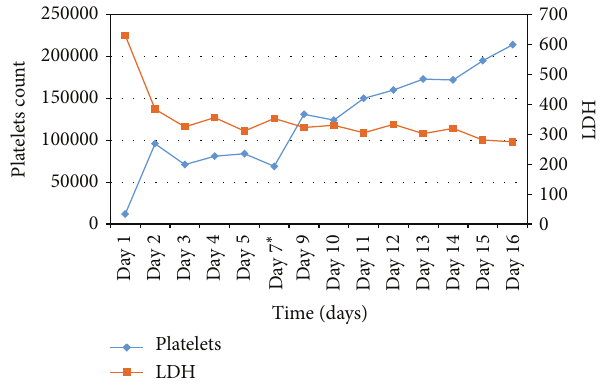
Figure 1: Platelets count and LDH values after each plasmapheresis session. ∗ No plasmapheresis was done on Day